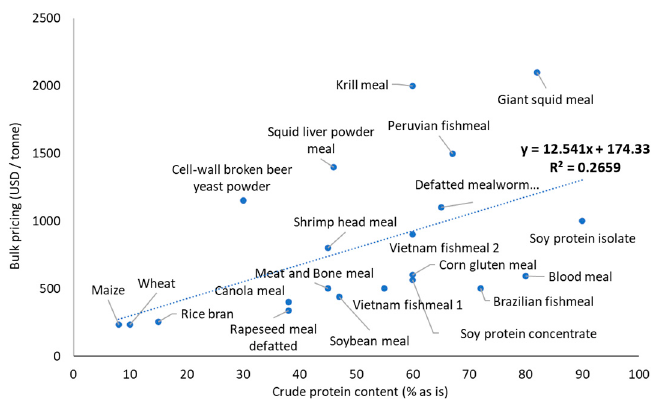
Figure 6. Price estimates for various raw feed and food-grade ingredients commercially available against their crude protein content estimates. Note ingredients were chosen from companies able to sustain 3000 to 120,000 tonnes per year production from Alibaba.com and their respective bulk FOB pricing.